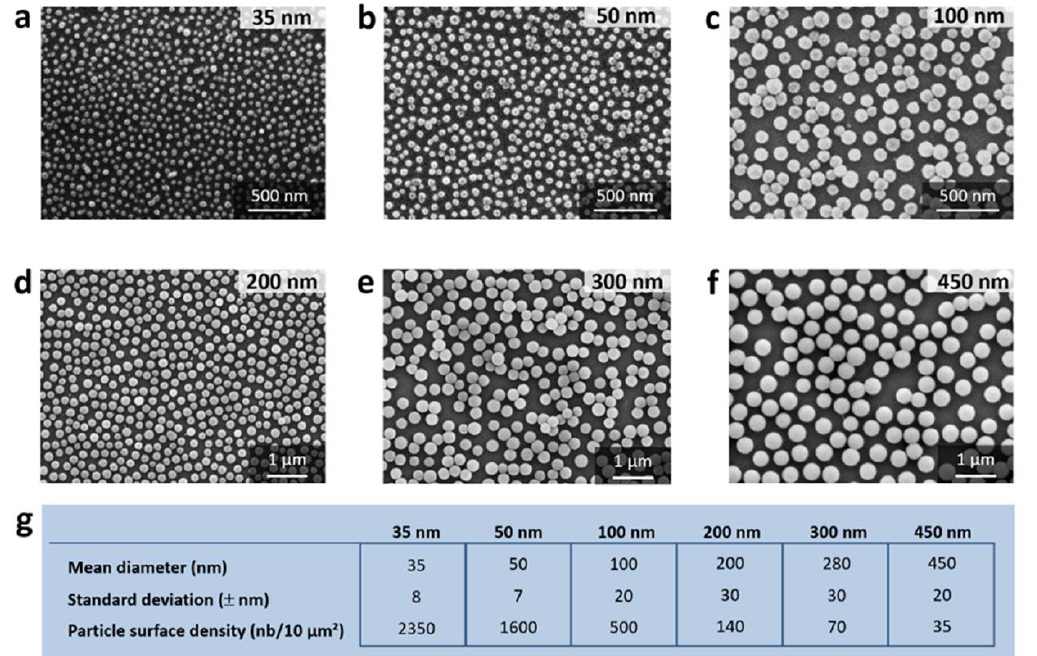
Figure 1. The nanoparticle-based monolayers. ( a – f ), scanning electron microscopy images of the different fluorescent silica nanoparticles (NPs) monolayers, constructed with 35 nm, 50 nm, 100 nm, 200 nm, 300, and 450 nm NPs, respectively. ( g ) Table of the mean sizes, standard deviation, and NPs surface density (number of particles per 10 µ m 2 ) corresponding to each NP size (all these data were obtained using ImageJ with manual thresholding). “ Reproduced from [19] ” .